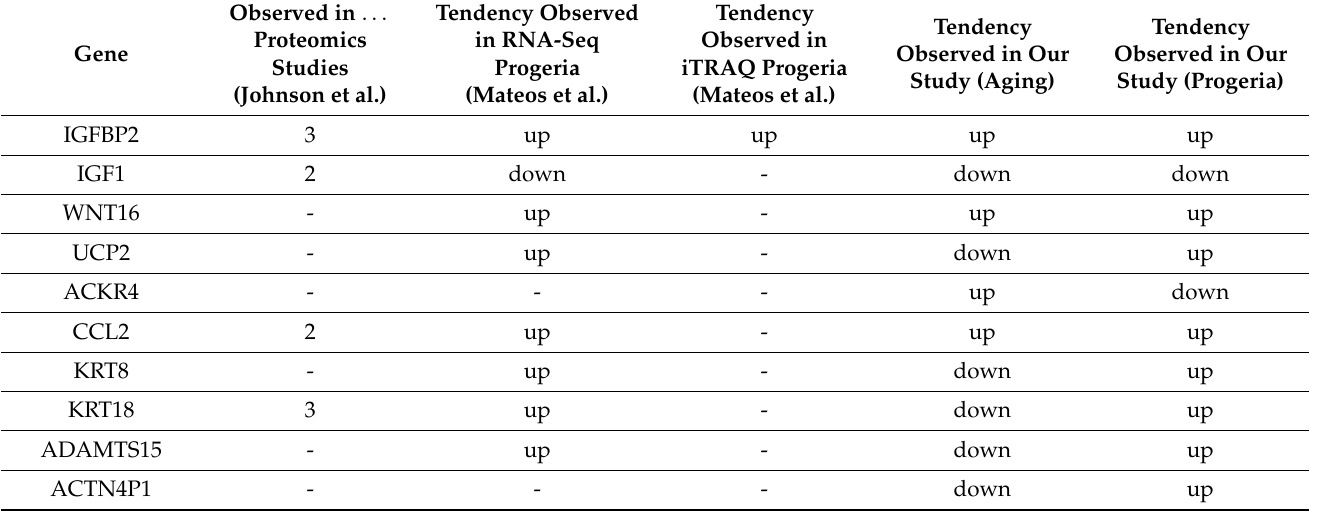
Table 3. Summary of the DEGs of special interest in the different proteomics studies. Columns indicate if/how often the gene was mentioned in aging-related proteomics studies (according to Johnson et al., 2020), Tendency in gene regulation observed in the RNA-Seq data analysis by Mateos et al. (2018), the iTRAQ analyses of Mateos et al. (2018), in our study regarding aging, in our study regarding